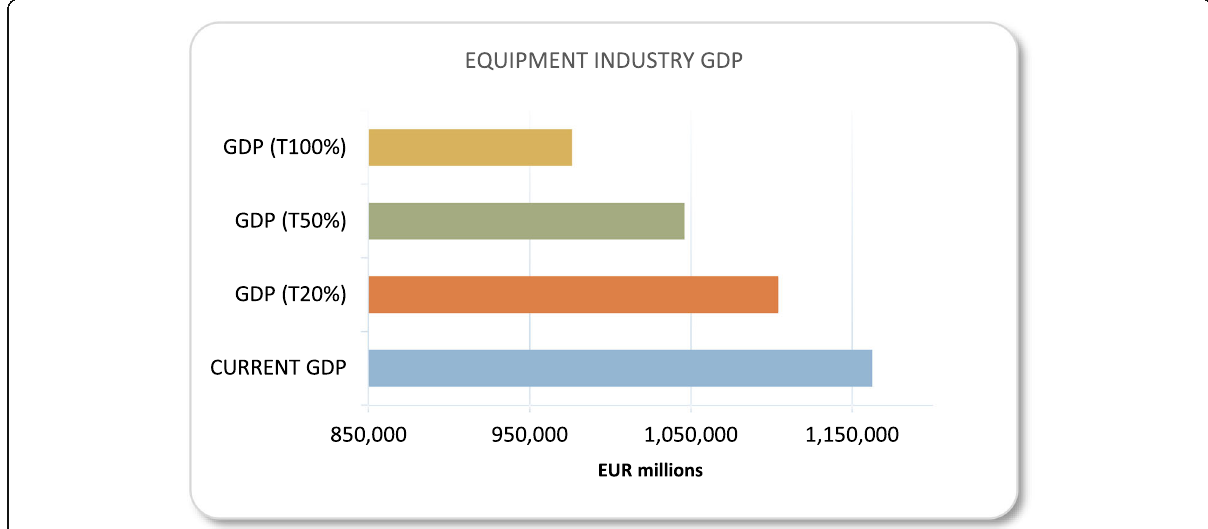
Fig. 9 GDP forecast of the Spanish equipment